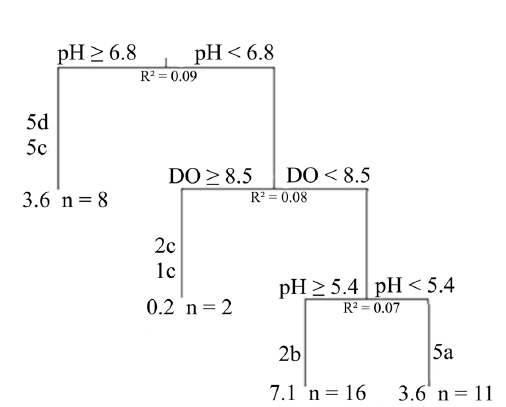
Figure 5. MRT model based on morphofunctional group densities and local predictors of the 37 reservoirs in the dry season (R 2 = 0.24). n is the number of sample units; the number on the left is the sum of the squares of the errors in each group. Each MFG shown contributed the most to the explanation of each group. DO = dissolved oxygen . Error = 0.7, CV Error = 1.2, SE = 0.09. Data used from Silva et al.